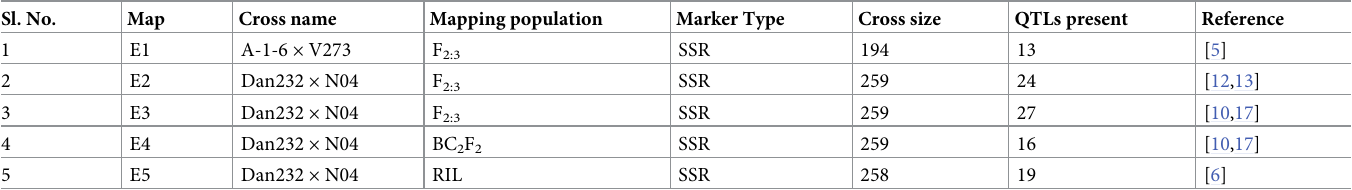
Table 2. Details of mapping studies used for popping traits in meta-QTL analysis. Sl.